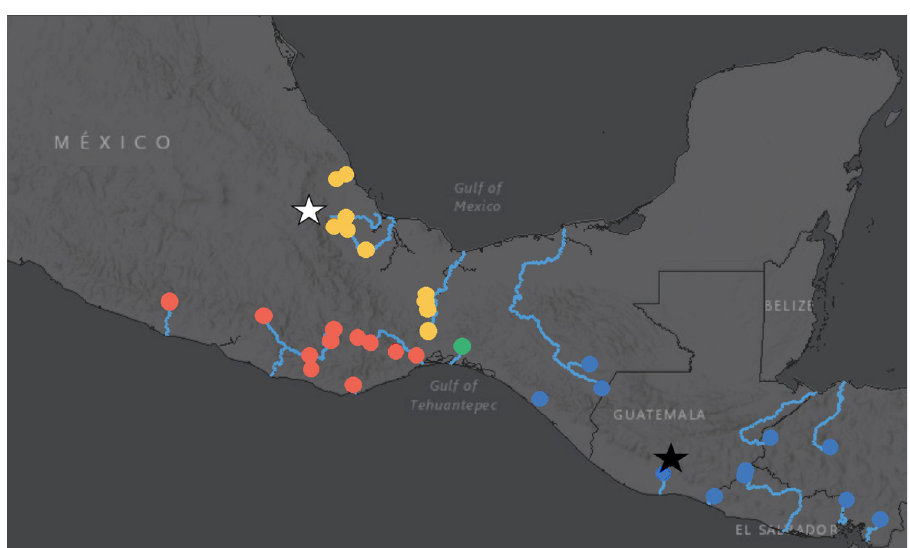
Fig 3. Distribution map of sampled localities. Red circles represent Pacific Mexico (PM); orange circles represent Atlantic Mexico (AM); green circles represent Pacific Southern Mexico (PSM); and blue circles represent Mexico and Central America (MCA). The white star; represents the type locality of P . gracilis ; the black star represents the type locality of P . pleurospilus . Map made in ArcMap 10.8.1 using the World Dark Gray Base map [76].